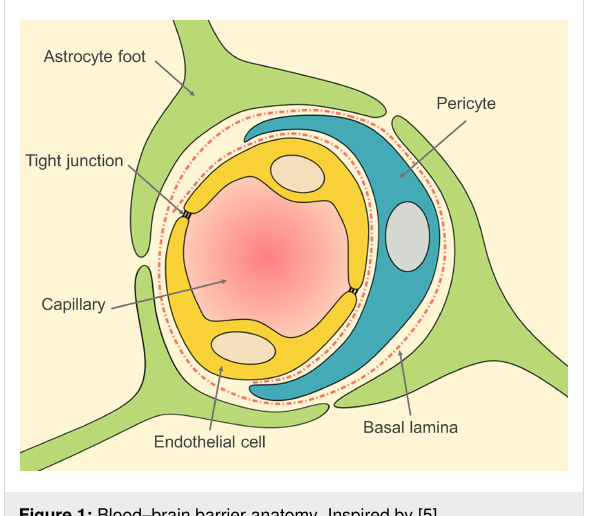
Figure 1: Blood–brain barrier anatomy. Inspired by